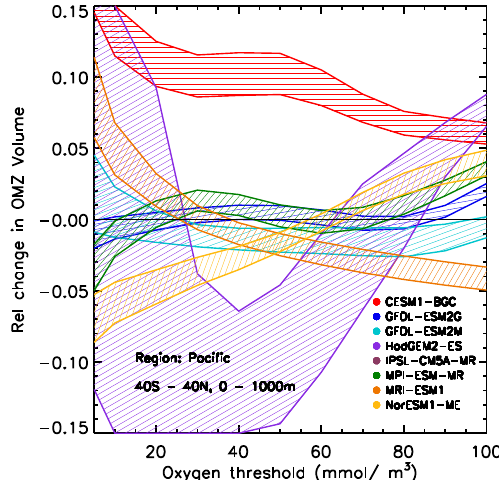
Figure 9. Relative change in the volume of oxygen minimum zones in the Pacific between 40 ◦ S and 40 ◦ N latitude to 1000m depth over 100 years (from the period 1960–1999 to the period 2060–2099) projected by individual CMIP5 models. Each model projection is shown as a patterned band that encompasses the natural variabil- ity (mean 100-year change ± 1 standard deviation over 40 years in the control sample). MPI-ESM-LR and HadGEM2-CC are not shown for clarity, as these are very similar to MPI-ESM-MR and HadGEM2-ES. IPSL-CM5A-MR model lies outside of the plot lim- its and is shown in Fig.